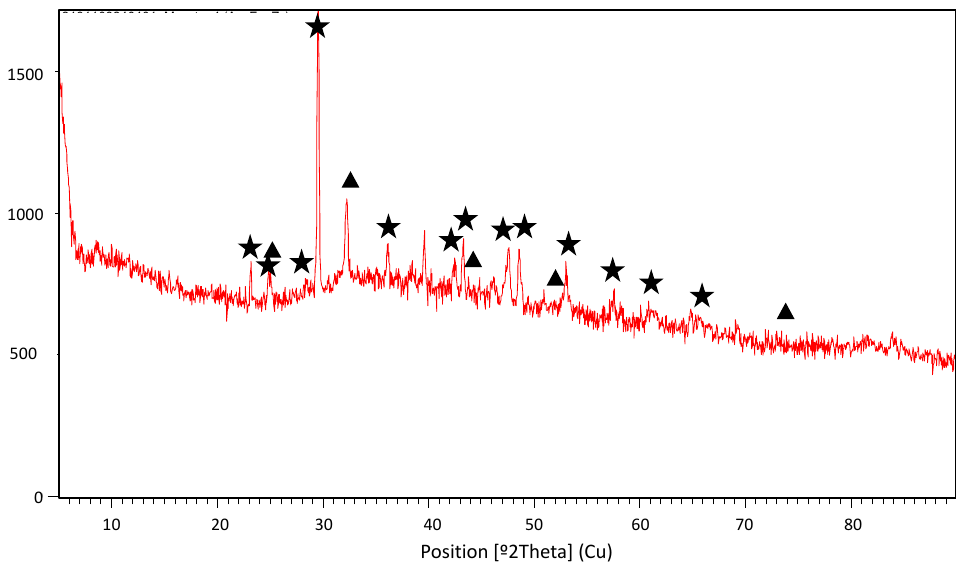
Figure 10. XRD patterns of alginate beads encapsulating biogenic iron precipitates after the continuous adsorption experiments with water from the river ( ▲ , As 0 ; , Zn 4 (AsO 4 ) 2 O).